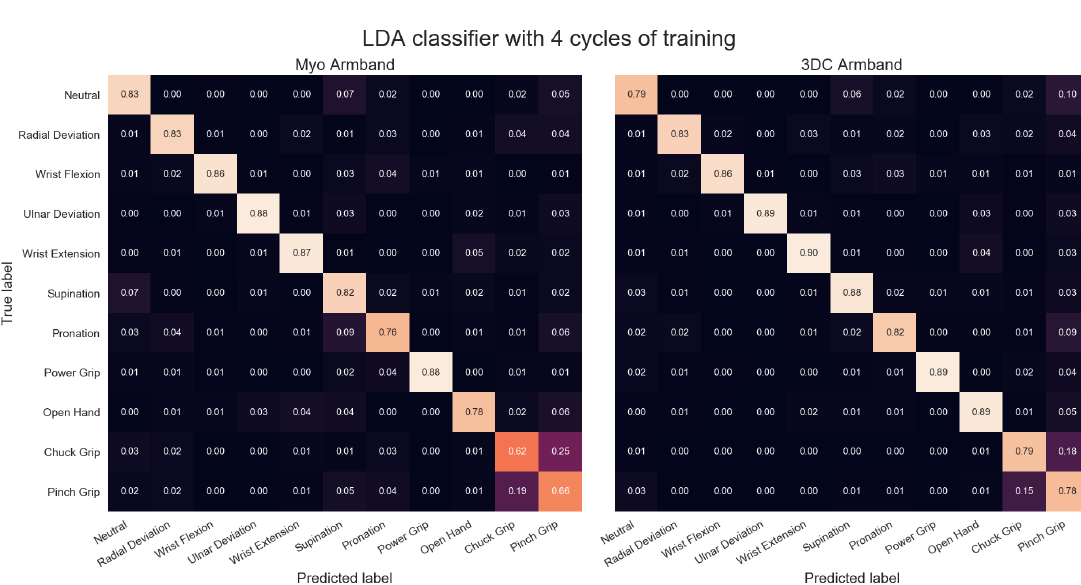
Figure 11. Comparison between the Myo and the 3DC Armband employing LDA for classification: The number of cycles corresponds to the amount of data employed for training (one cycle equals 5 s of data per gesture). The Wilcoxon Signed Rank test is applied between the Myo and the 3DC Armband. The null hypothesis is that the median difference between pairs of observations (i.e., accuracy from the same participant with the Myo or the 3DC Armband) is zero. The p-value is shown when the null hypothesis is rejected (significant level set at p = 0.05). The black line represents the standard deviation calculated across all 22 participants.